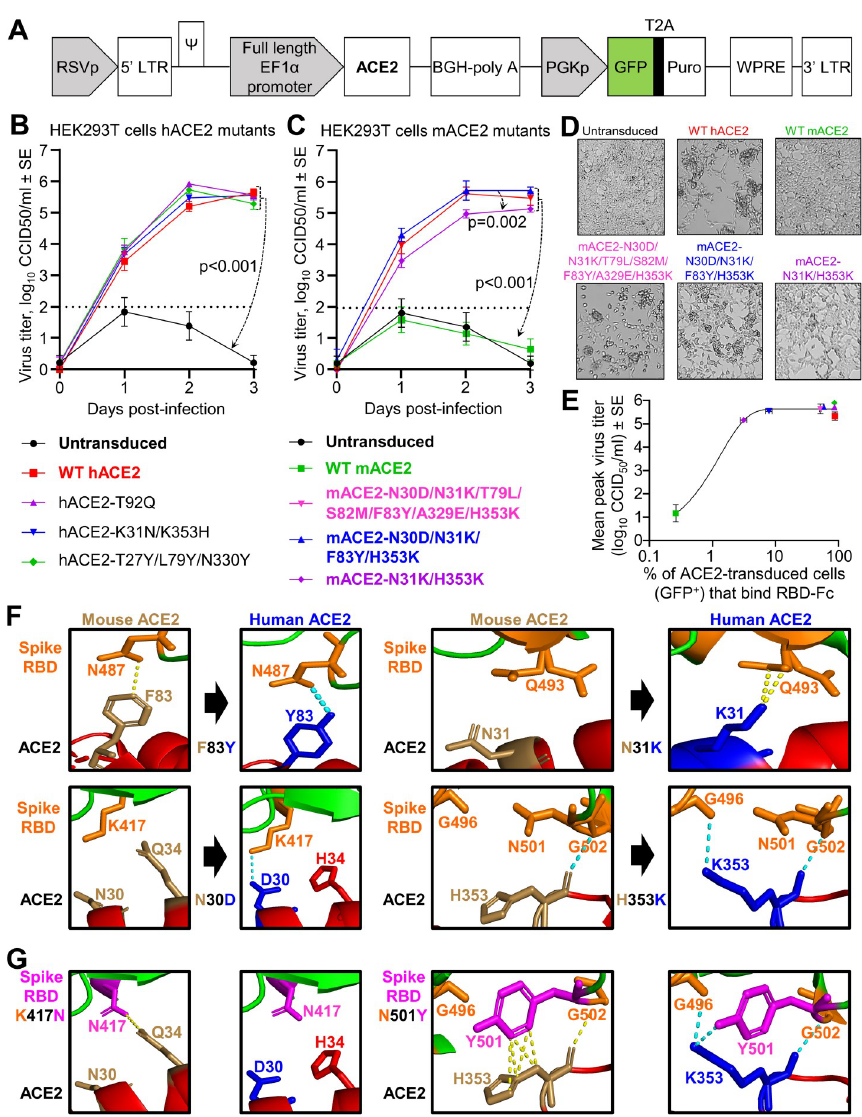
Fig 1. Mutational analyses of human and mouse ACE2 using ACE2-lentiviruses in vitro . A) Schematic of pCDH-EF1 α -ACE2-BGH-PGK-GFP-T2A-Puro lentiviral vector. B-C) Growth kinetics of SARS-CoV-2 over a three day time course in HEK293T cells transduced with WT or mutant hACE2 (B) or mACE2 (C) infected at MOI = 0.1. Data is the mean of 2–4 independent experiments with 2–3 replicates in each and error bars represent SEM. Statistics was determined using Repeated Measures Two-Way ANOVA comparing mock transduced (for B) or WT mACE2 (for C) with all others, and comparing mACE2-N30D/N31K/F83Y/H353K with mACE2-N31K/H353K. D) Inverted light microscopy images of HEK293T cells transduced with the indicated ACE2 lentivirus and infected with SARS-CoV-2 at MOI = 0.1. Images were taken at day 3 post infection and were representative of triplicate wells. E) SARS-CoV-2 spike RBD-Fc flow cytometry-based binding assay with ACE2-transduced cell lines. The percentage of ACE2-transduced cells (GFP + ) with RBD-Fc bound (x-axis) (n = 2 with an additional independent experiment showing similar results) is plotted against mean peak viral titer (y-axis) from ‘B’ or ‘C’. Symbol colors and shapes match the legend presented in ‘B’ or ‘C’ for all cell lines. A sigmoidal curve was fitted in GraphPad Prism 8.2.1. See S2 Fig for gating and GFP + and RBD-Fc + percentages. F) Crystal structure of the spike RBD:hACE2 complex (PBD: 6M0J) [115] viewed in PyMOL and zoomed in on key interactions between ACE2 residues identified in ‘C-D’ (hACE2 = blue, mACE2 = brown) and spike RBD residues (orange). Yellow dotted lines represent any contacts between chains within 3.5 Å , and blue dotted lines represent polar contacts. Direction of black arrows indicate predicted enhanced interactions. G) K417N and N501Y mutations (magenta) were introduced in the spike RBD to mimic the beta (B.1.351) and alpha (B.1.1.7) SARS-CoV-2 variants.